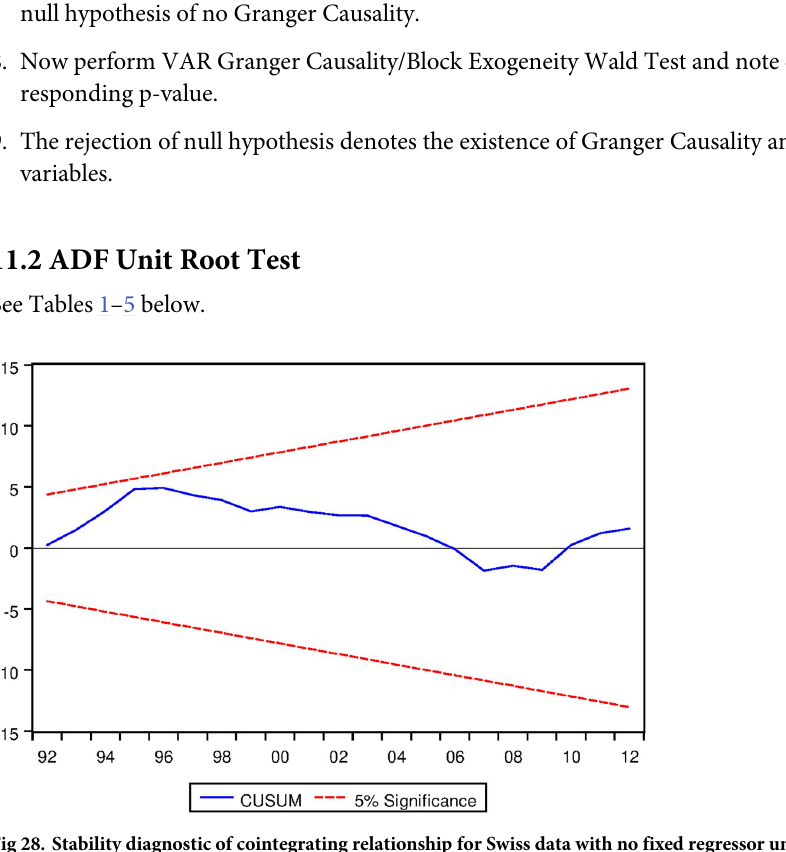
Fig 28. Stability diagnostic of cointegrating relationship for Swiss data with no fixed regressor under Fisherian